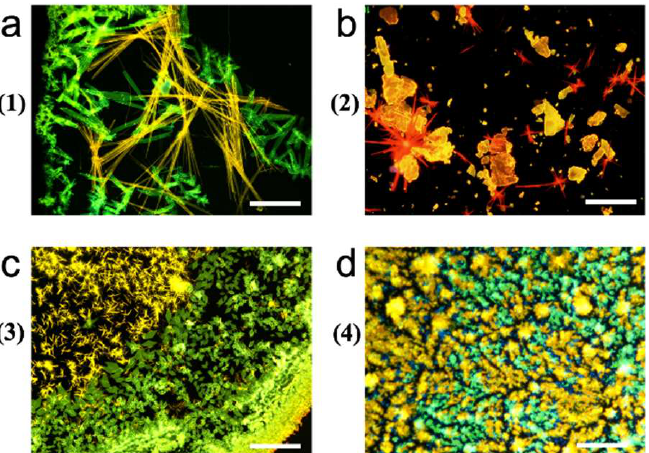
Figure 3. Fluorescence images of polymorphic, thin deposits of ( a ) Thieno(bis)imide end-functionalized terthiophene ( 1 ); ( b ) 2,3-thieno(bis)imide-ended oligothiophenes bearing unsaturated ethylene ( 2 ); ( c ) 2, 3-thieno(bis)imide-ended oligothiophenes bearing inner bridges ( 3 ); and ( d ) 2,2′-(5,5′- (Ethyne-1,2-diyl)bis(thiophene-5,2-diyl))bis(5-hexyl-4H-thieno[2,3-c]pyrrole-4,6(5H)-dione) ( 4 ).